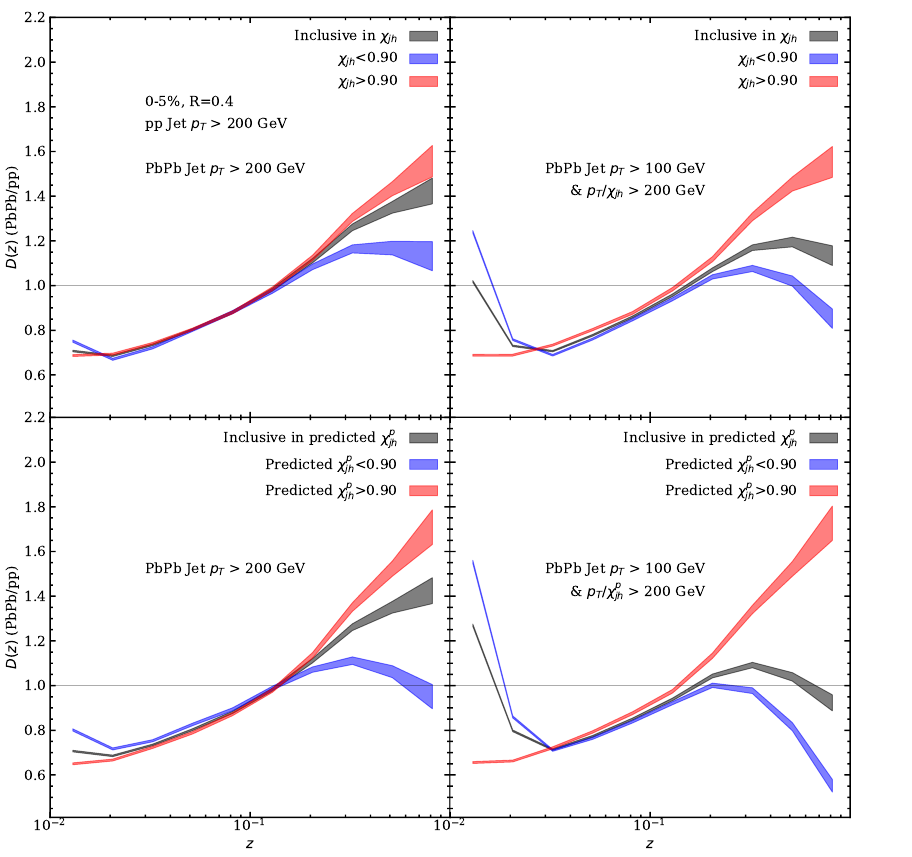
Figure 16 . Results comparing the JFF ratio between PbPb and pp for the true χ jh (top row) and predicted χ p (bottom row), and the FES (left column) with the IES (right jh